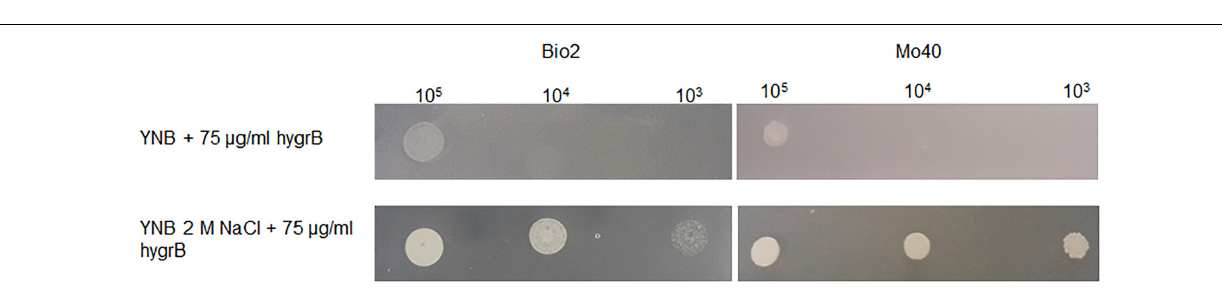
FIGURE 6 | Test for cationic drug resistance. D. hansenii cells were spotted on YNB plates supplemented with 75 µ g/ml Hygromycin B and containing or not 2 M NaCl. The plates were recovered after 3 days of growth at 30 ◦ C.